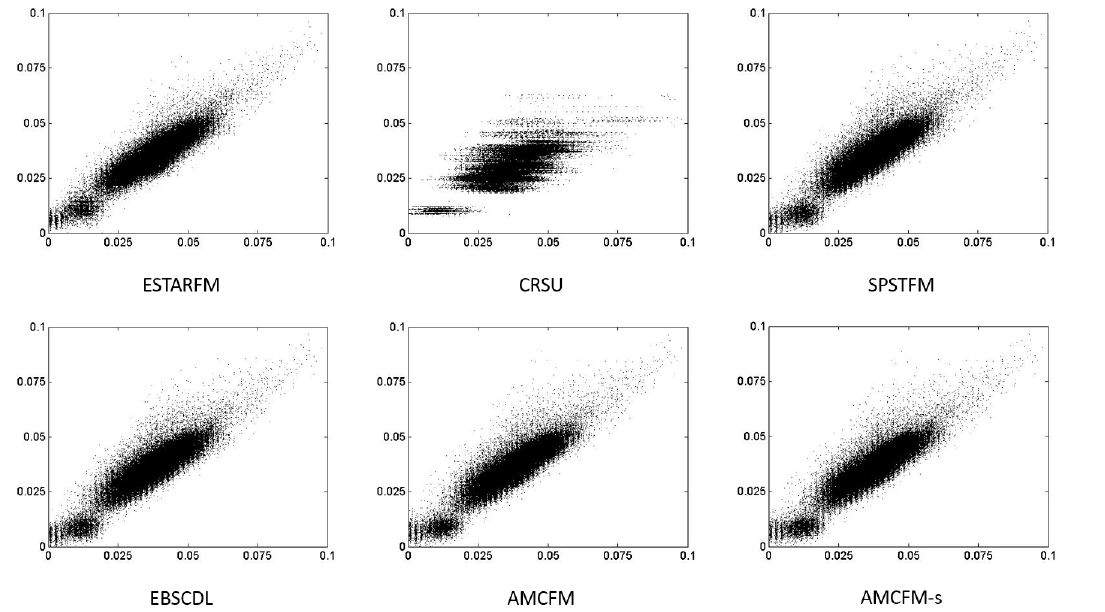
Figure 5. Scatter plots of red band of image 1. Abscissa is the true reflectance and ordinate is the predicted